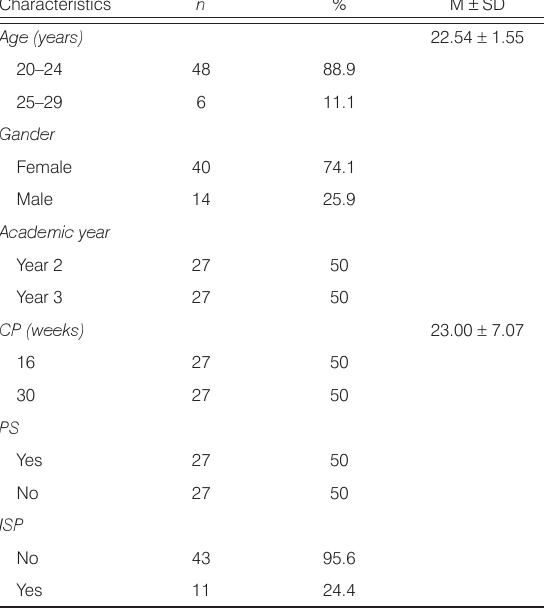
Table 1. Characteristics of participants in nursing assessment OSCE ( N =